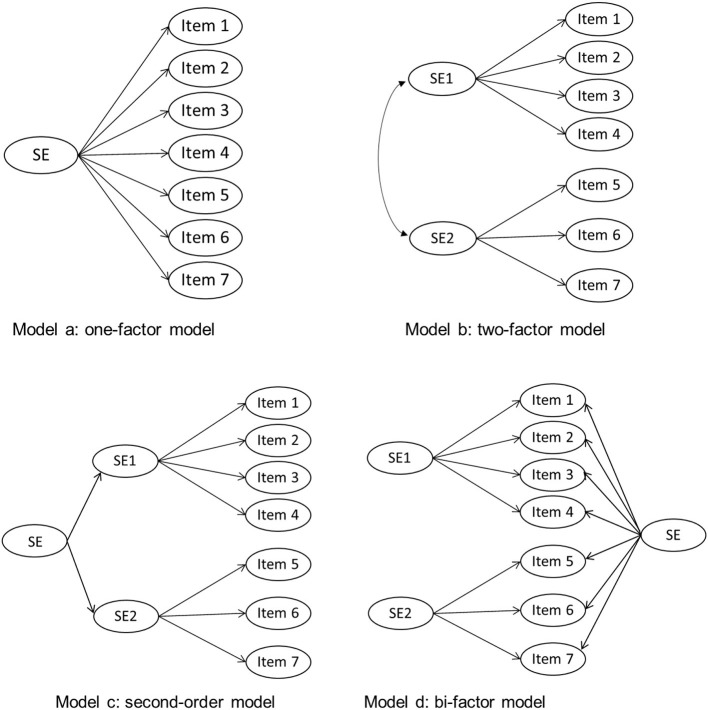
Four alternative test models for social engagement scale.